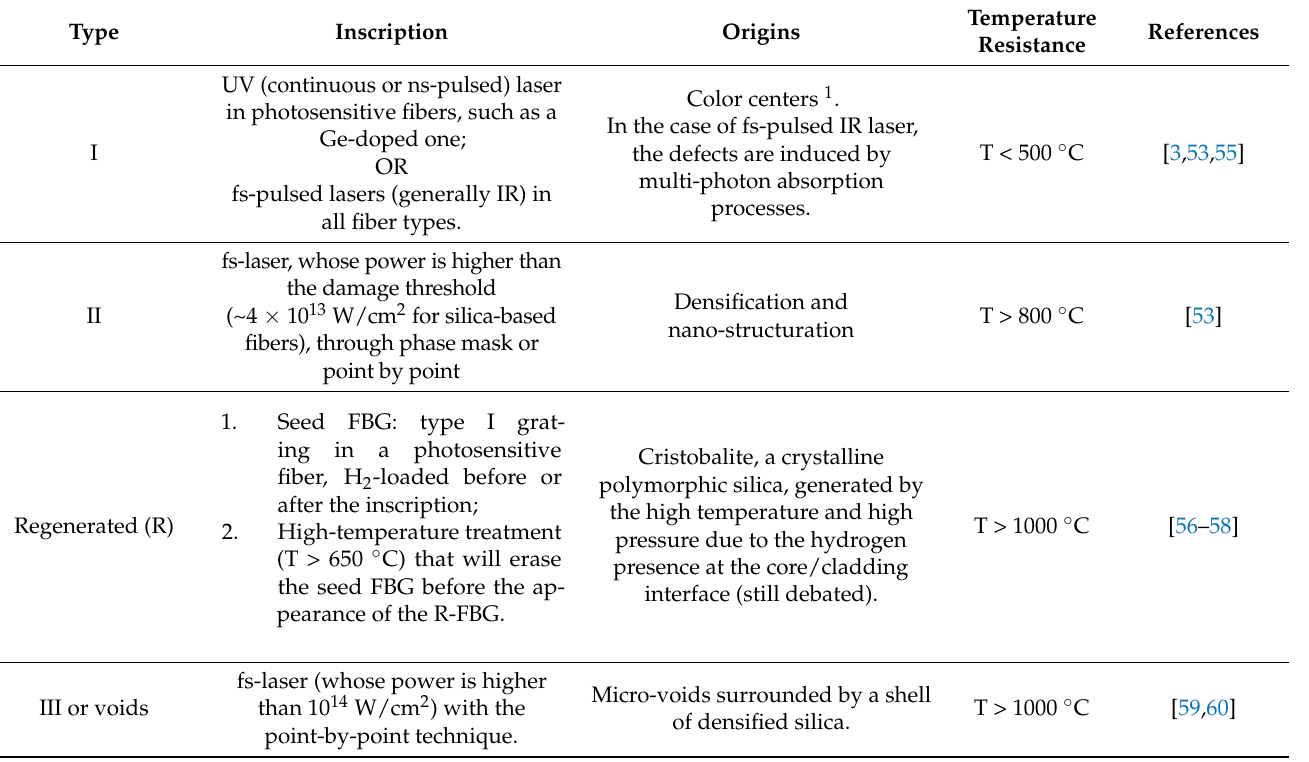
Table 2. Fiber Bragg grating classification with the inscription conditions, their origins, and their temperature operating